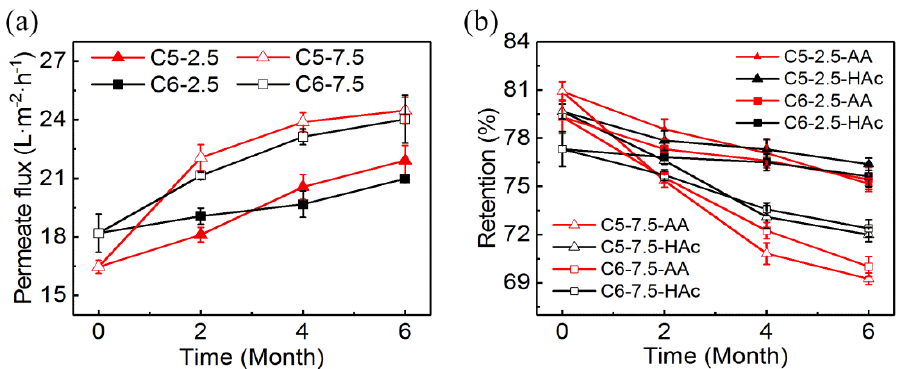
Figure 5. Effects of continuous exposure to the acid solutions on the ( a ) permeate flux and ( b ) acrylic acid and acetic acid retentions. The feed solution contained 2.5% acrylic acid and 1.5% acetic acid; temperature: 25 °C; pressure: 3.5 MPa.